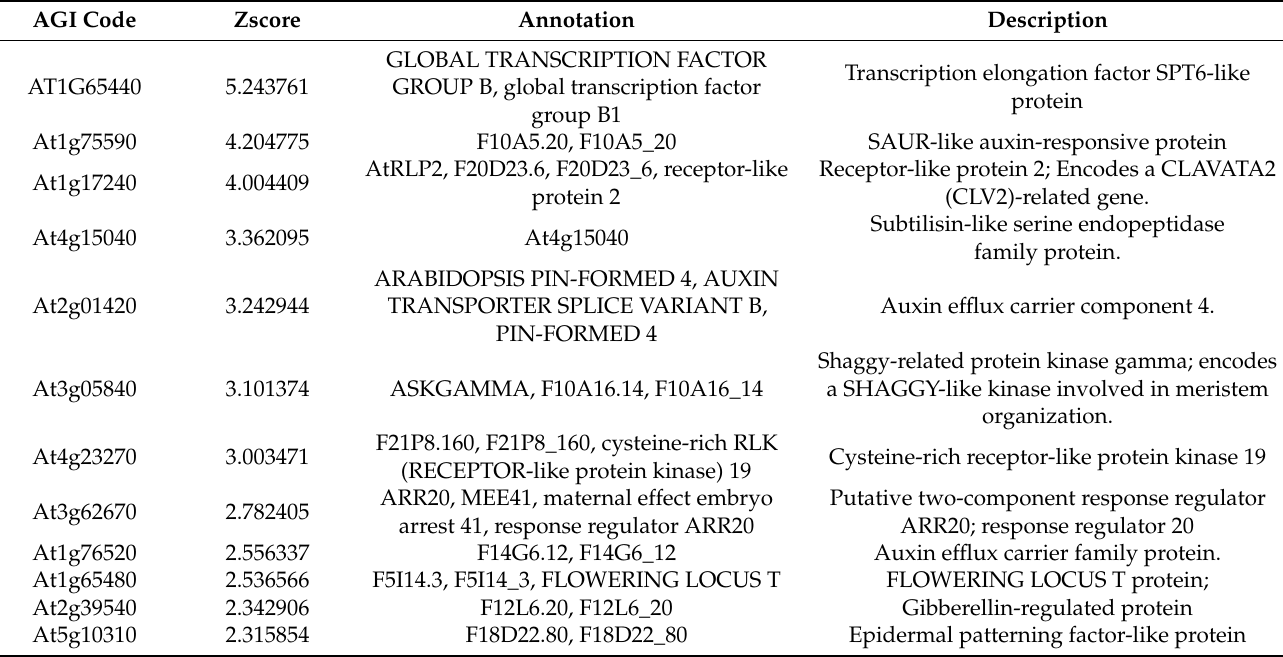
Table 1. Up-regulated genes involved in hormones, stomatal development abiotic stress responses. AGI